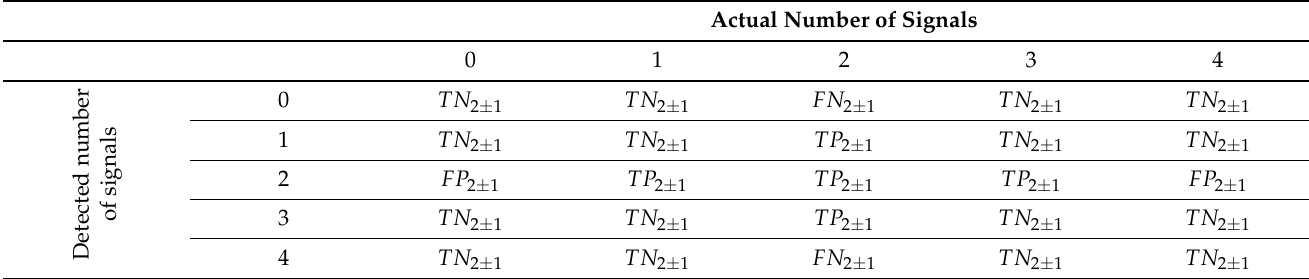
= 2 and d = 1. d with k ±